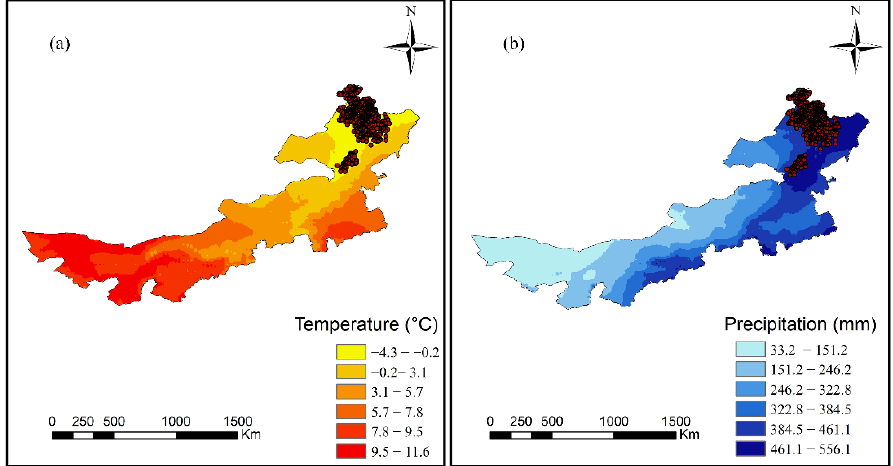
Figure 2. Mean annual temperature ( a ) and mean annual precipitation ( b ) in the state-owned forest region of the Greater Khingan Mountains.